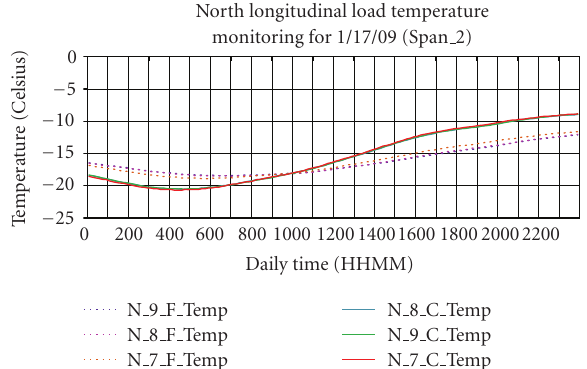
Figure 7: North longitudinal load temperature monitoring for span two (1/17/09).